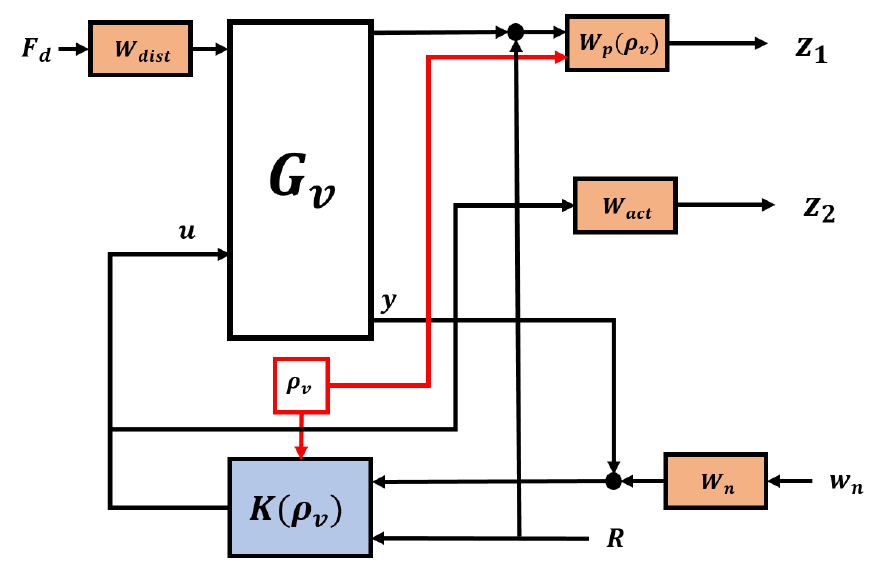
Figure 6. Closed-loop interconnection structure of velocity